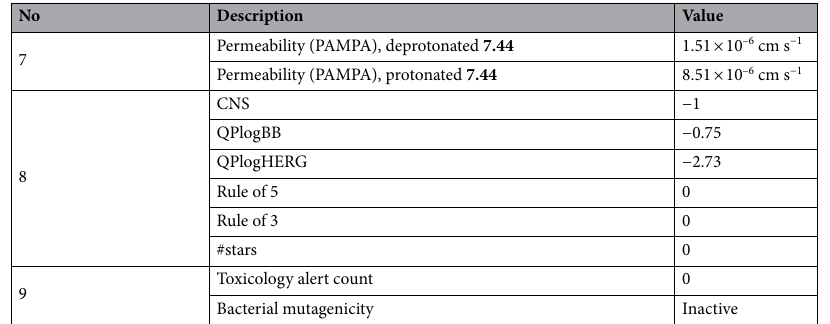
Bacterial Table 3. Predicted pharmakokinetic and toxicological properties of 7.44. The pharmacokinetic properties were predicted as described in the text (PAMPA permeability) or with the Qikprop module of the Schrödinger software suite. CNS: The predicted central nervous system activity (–2 (inactive) to + 2 (active)). QPlogBB: The predicted brain-blood partition coefficient for oral drugs (recommended range: −3.0 to 1.2). QPlogHERG: the predicted IC 50 value for blockage of HERG K + channels (≥ -5 recommended). Rule of 5: number of violations of Lipinski’s rule of five (recommended £ 4). Rule of 3: number of violations of Jorgensen’s rule of three (recommended £ 2). #stars: the number of properties falling outside the 95% range of similar values for known drugs (0 (good) to 5 (bad)). The toxicological properties were predicted with DEREK Nexus and SARAH Nexus. Toxicology alert count: number of predicted toxicophores. Bacterial mutagenicity: predicted bacterial mutagenicity in vitro.